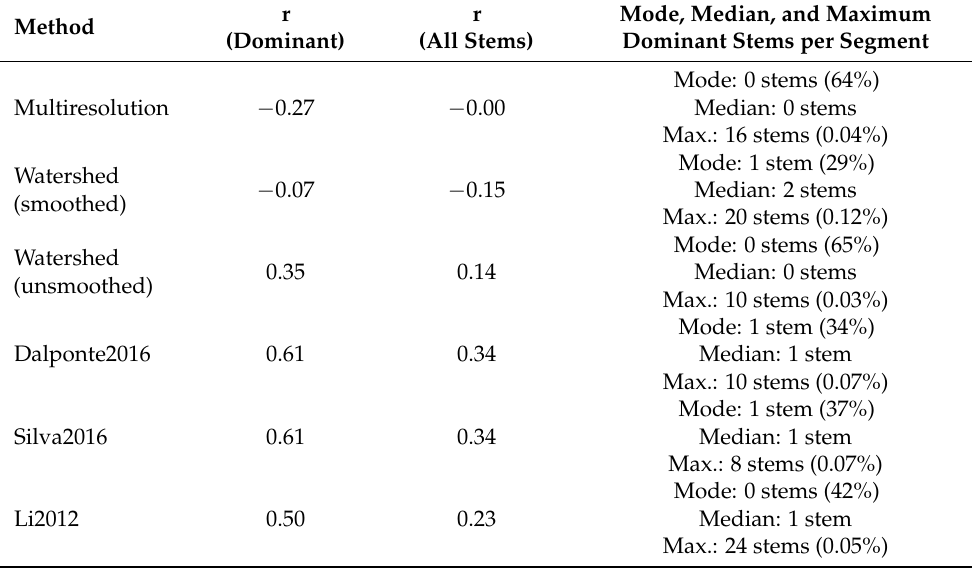
Table 5. Correlations between stem counts (dominant- or all trees) and segment counts per